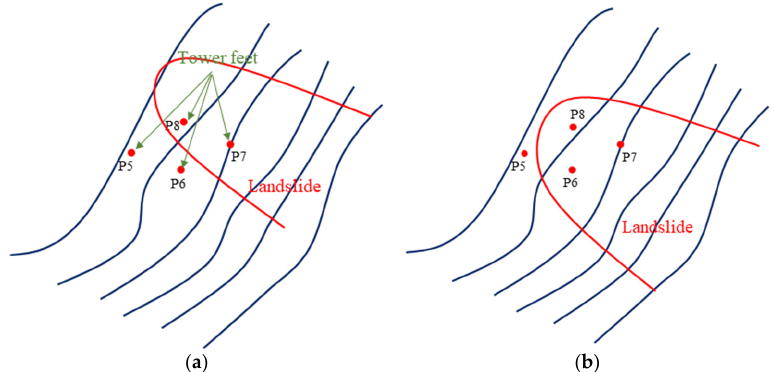
Figure 9. Two failure cases of towers on the landslide. ( a ) Case 1; ( b ) Case 2.